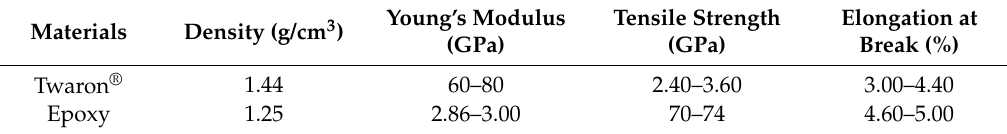
Figure 3. Setup of the ballistic impact: ( a ) Ballistic range; and ( b ) Schematic of the ballistic range for composite ballistic performance evaluation.